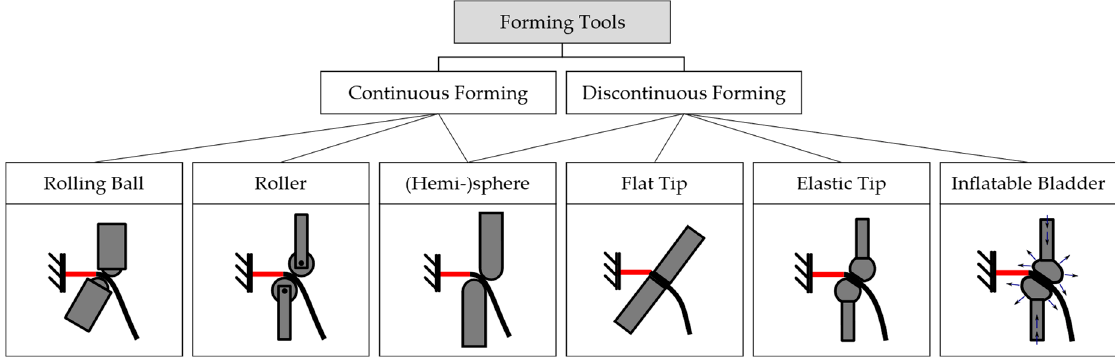
Figure 7. Forming tool variants and concept sketches.